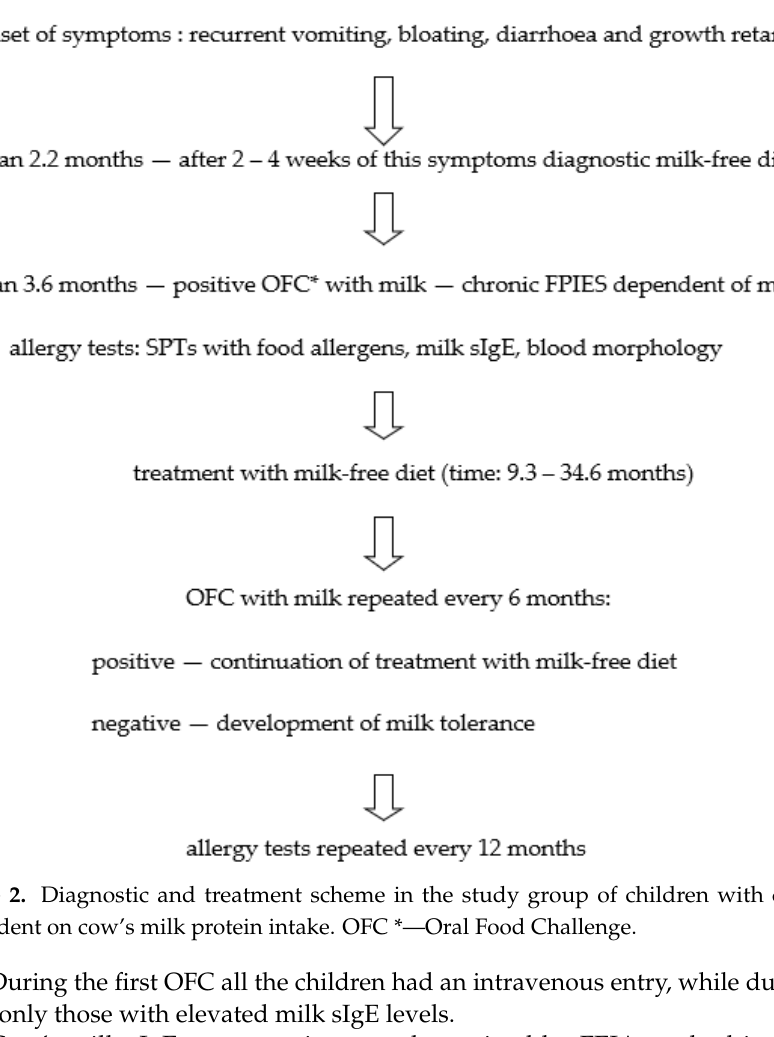
Figure 2. Diagnostic and treatment scheme in the study group of children with chronic FPIES dependent on cow’s milk protein intake. OFC *—Oral Food